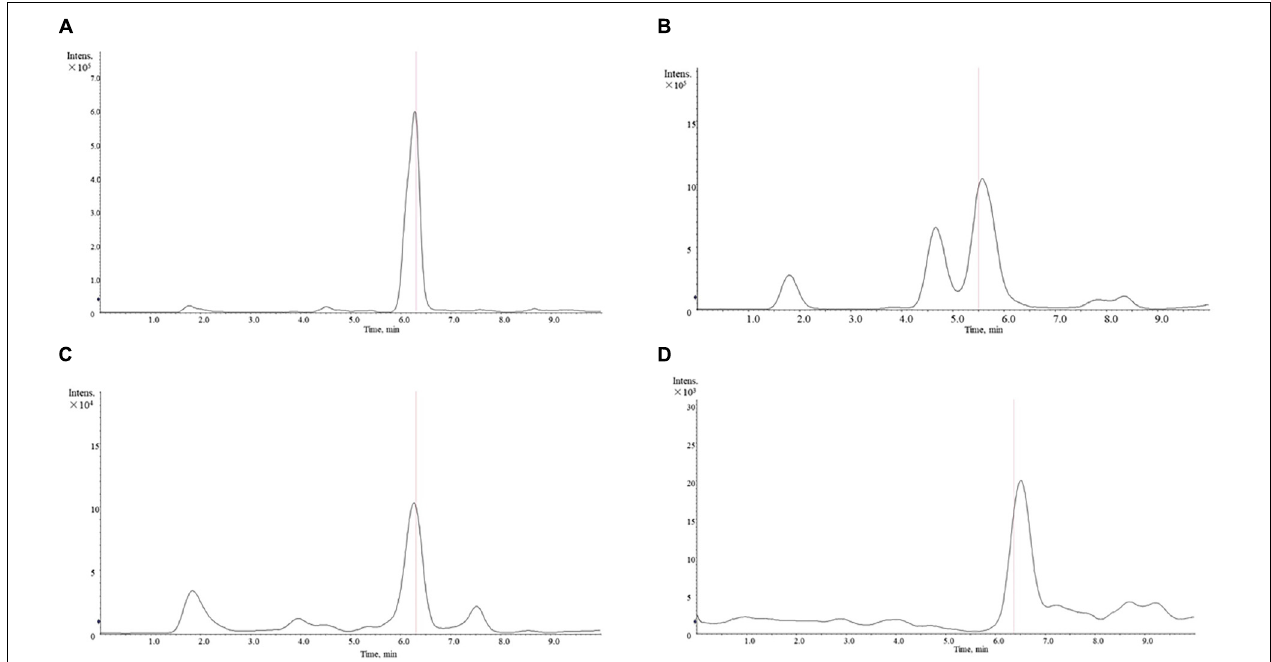
FIGURE 2 | Mass spectrum of amino acid content in ACC. (A) Alanine. (B) L-proline. (C) L-hydroxyproline. (D) Glycine.